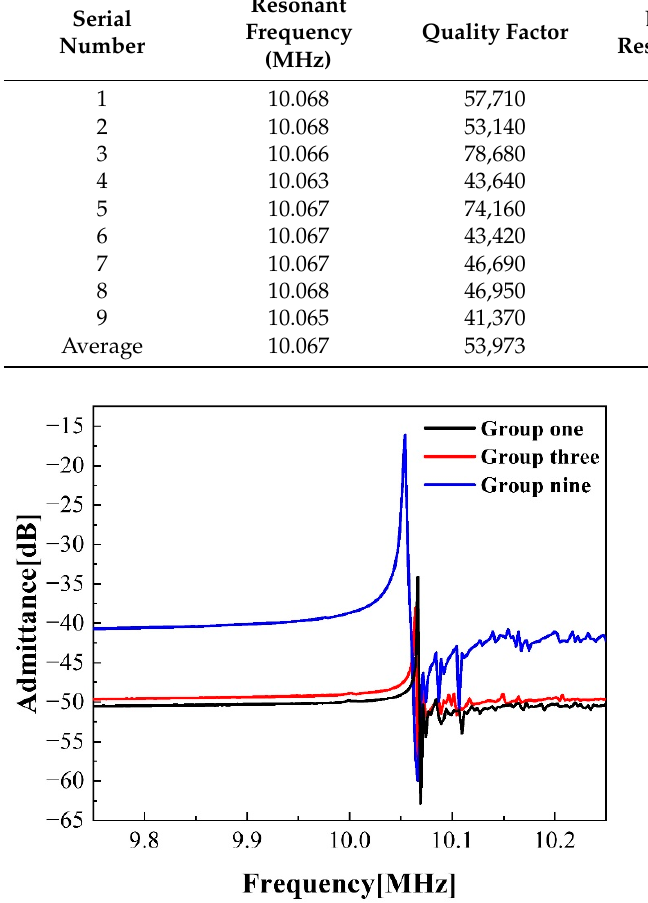
Figure 11. Admittance characteristics of the QCM with double-finger